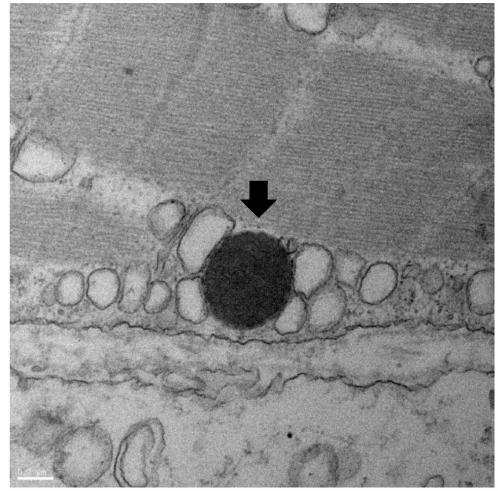
Figure 4. RLOs detected in the transmission electron microscopy (TEM) assay: Microorganisms with a diameter of 500 nm and a trilaminar